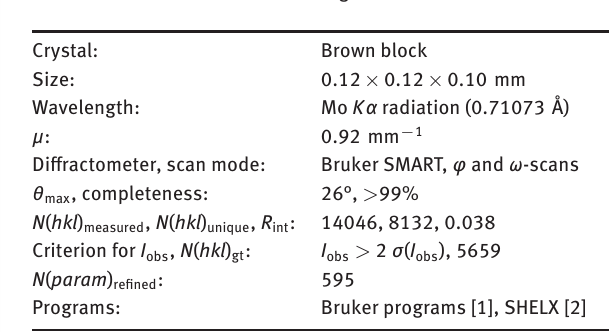
Table 1: Data collection and handling.